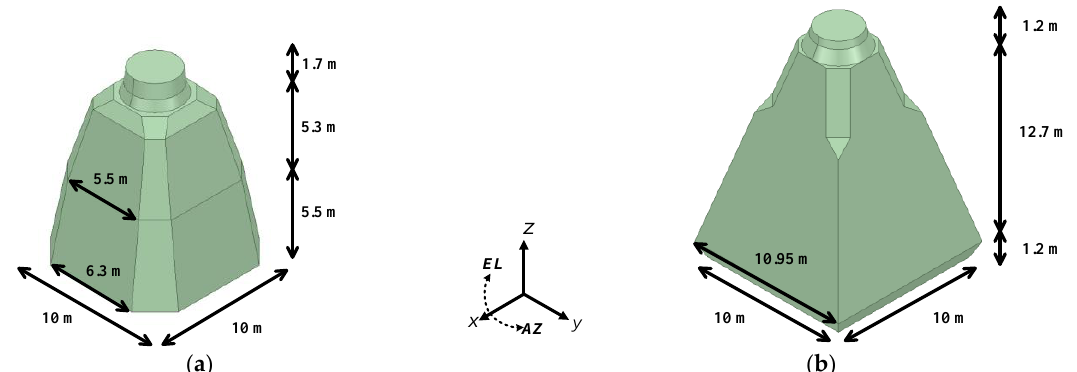
Figure 3. Dimension of the integrated mast. ( a ) initial mast, ( b ) optimized mast.